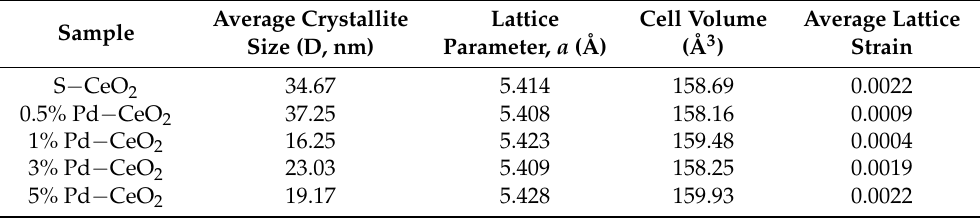
Table 1. The average crystallite size (D), lattice parameter, cell volume, and average lattice strain of S − CeO 2 and Pd − CeO 2 NPs. Average Crystallite Lattice Cell Volume Average Lattice Sample Size (D, nm) Parameter, a (Å) (Å 3 )